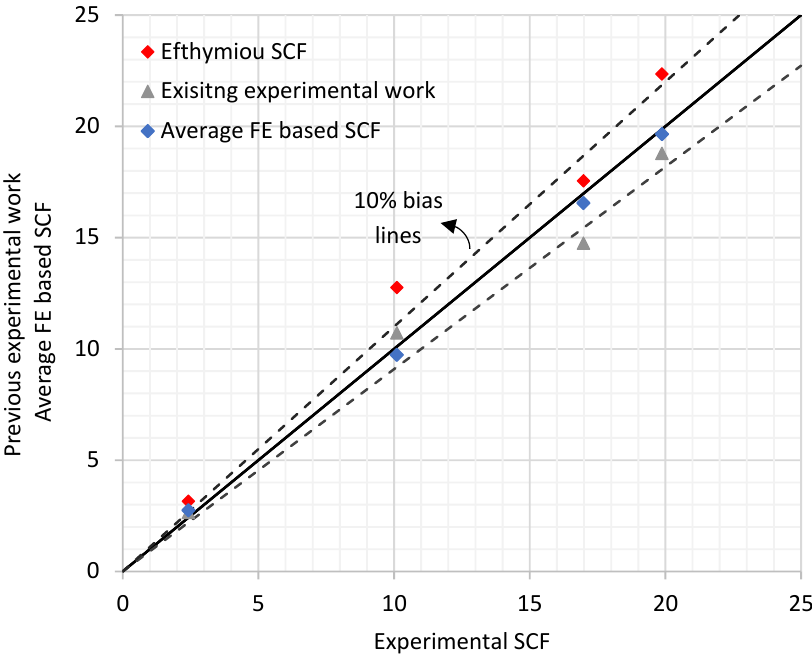
Figure 17. Present experimental mean SCF values against parametric Efthymiou, previous experimental work and FE based SCF values. Table 9. FEA based SCF compared to SCF from specimen DT 1—Quadrant 3 (corrected for location of “a” and “b”).